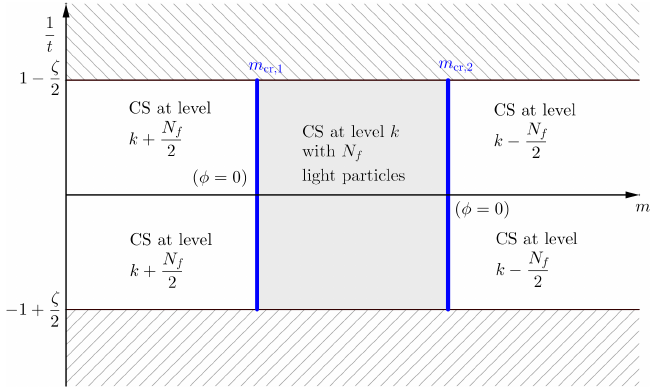
(cid:0) (cid:1) m, 1 t